Question: Condense the content of this figure into a single sentence.
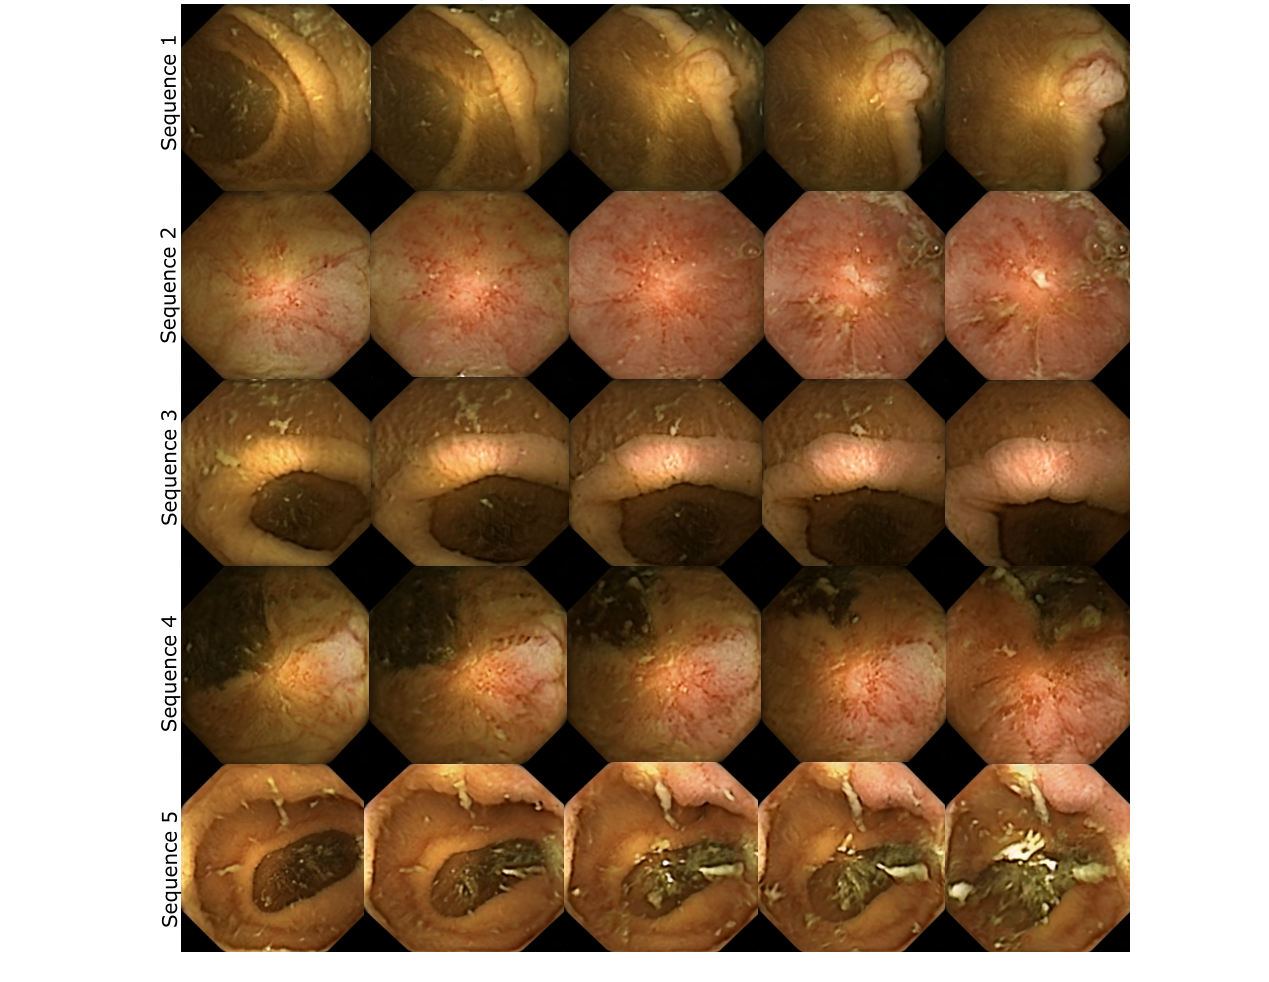
Answer: The ﬁgure shows ﬁve disease progressions shown to the experts as part of task 3. The severity increase from left (image 1) to right (image 5). The severity ratings and plausibility histogram corresponding to each sequence is shown in Fig.9 below.